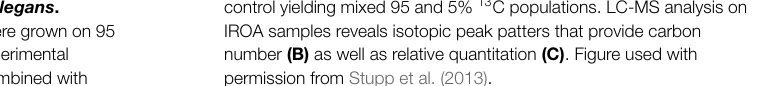
control yielding mixed 95 and 5% 13 C populations. LC-MS analysis on IROA samples reveals isotopic peak patters that provide carbon number (B) as well as relative quantitation (C) . Figure used with permission from Stupp et al.